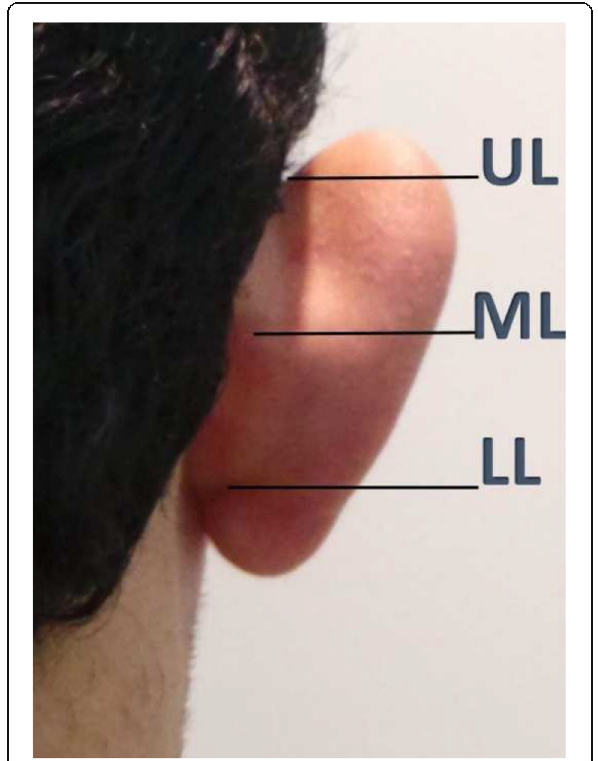
Fig. 2 Right auricle showing 2 of the common causes of auricular protrusion: (1) underdeveloped antihelical fold and (2) hypertrophied conchal